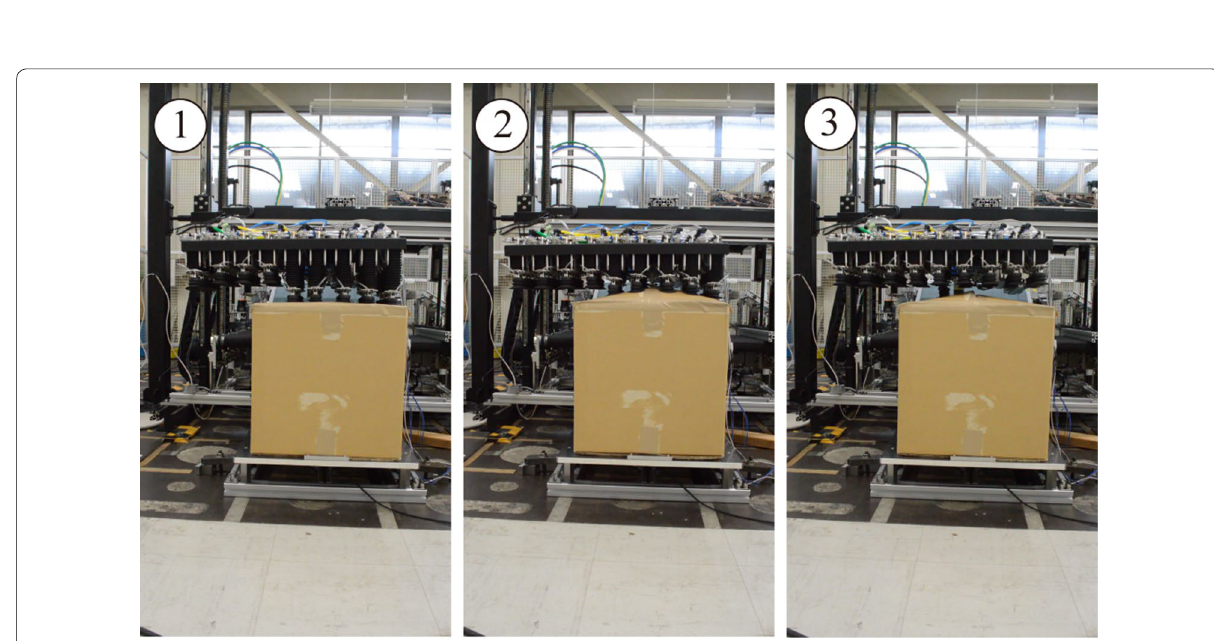
Fig. 42 Experimental scene for evaluation of the contraction force of the end-effector